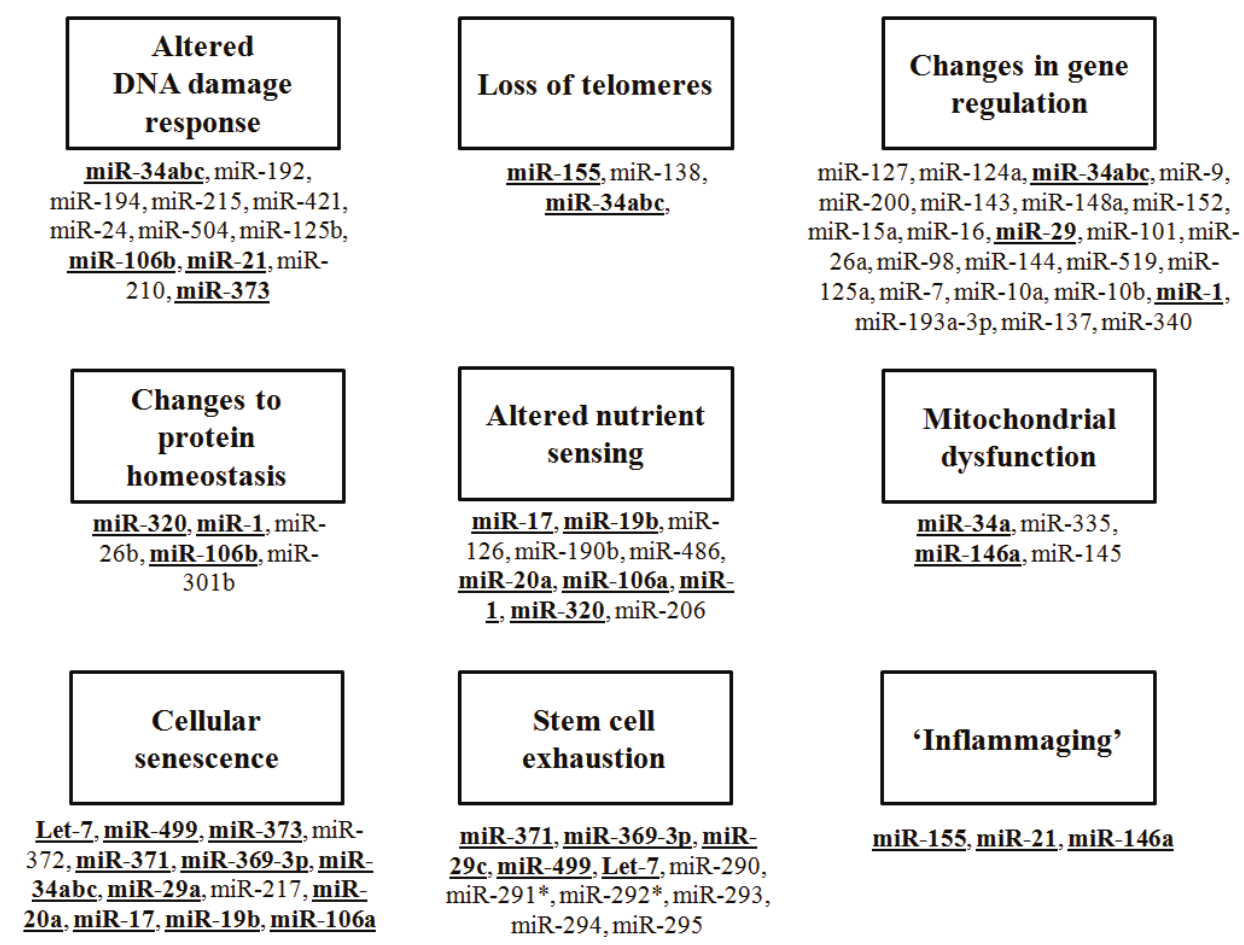
Figure 1. The hallmarks of eukaryotic ageing and the miRNAs that may interact with these pathways. MicroRNAs that have been to be associated with each feature are indicated. Those miRNAs that are known to be involved in more than one feature are given in bold, underlined